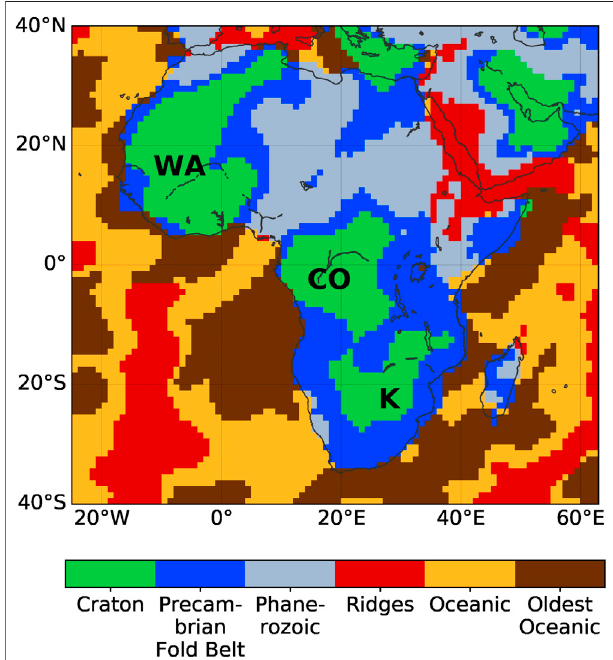
FIGURE 3 | Tectonic regionalization map of the AF2019 tomography model.Theclustersaretranslatedintodistincttectonicdomains,basedonthe de fi nitions of Lekic and Romanowicz (2011) and Schaeffer and Lebedev (2015). The three continental cratons are indicated as WA (cid:1) West African Craton, CO (cid:1) Congo Craton, K (cid:1) Kalahari